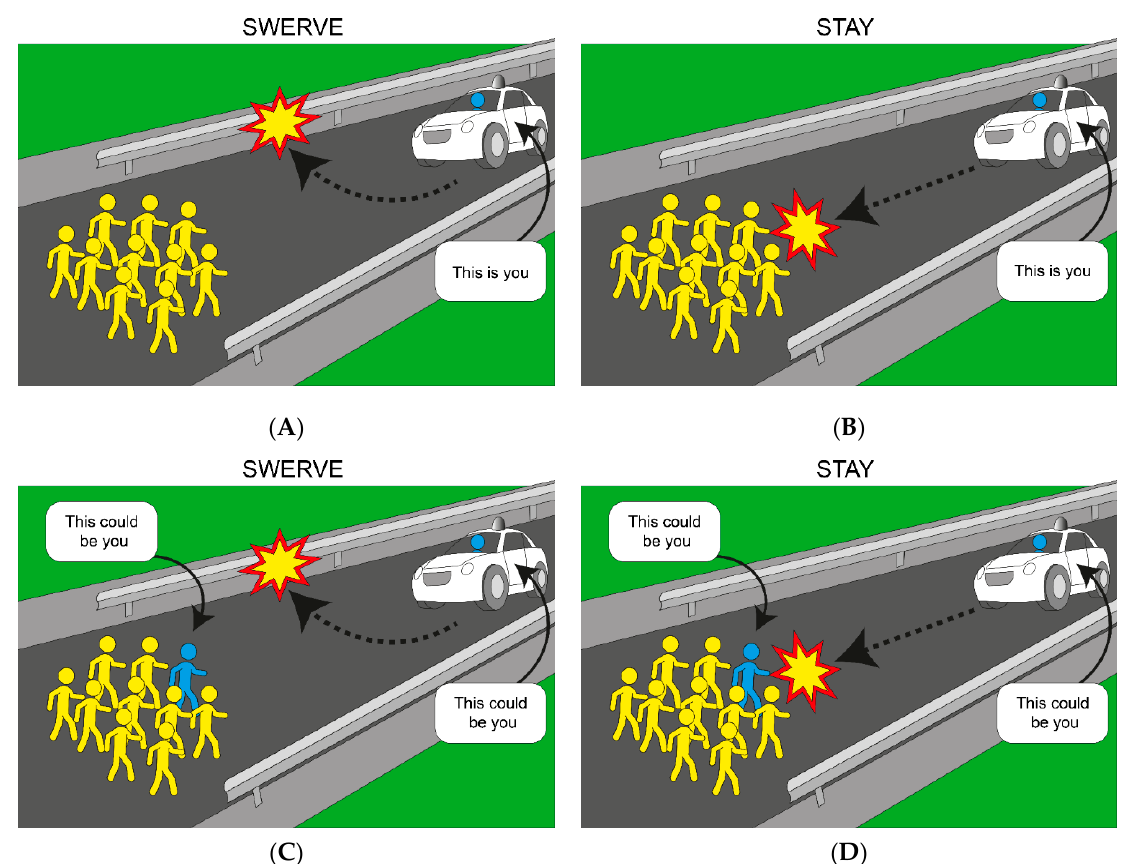
Figure 2. A visual representation of an AV crash scenario with partial and full PT accessibility. Note. Panel A : a utilitarian AV with partial PT accessibility. Panel B : a non-utilitarian AV with partial PT accessibility. Panel C : a utilitarian AV with full PT accessibility. Panel D : a non-utilitarian AV with full PT accessibility.